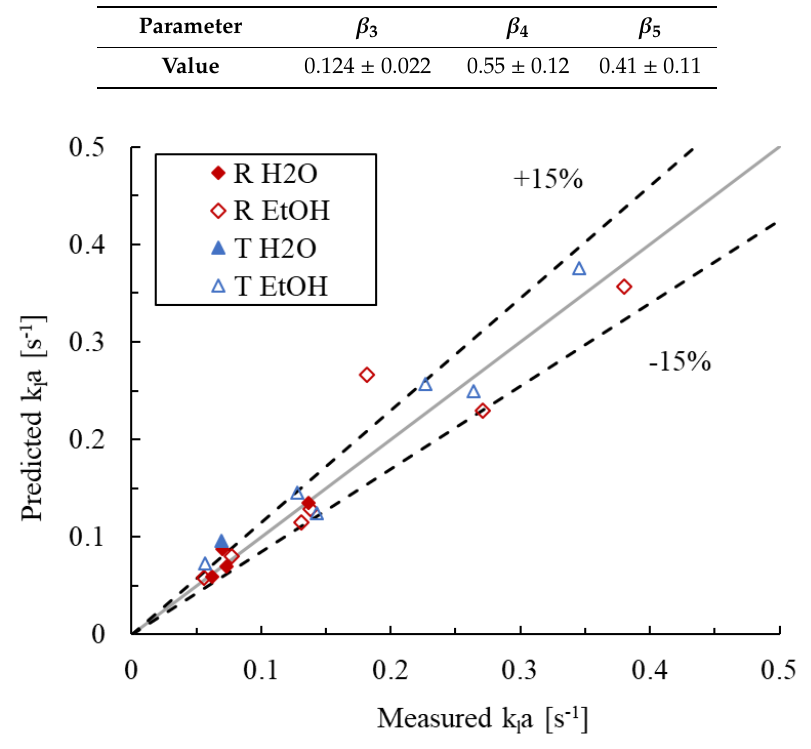
Table 3. k l a model fits and 95% confidence intervals for LL-Rhombus and LL-Triangle with water and 0.5 wt% aqueous ethanol as the liquid phases over the ranges of 0.565 < (cid:15) < 6.91 W / kg and 0.14 < u g / u l < 0.56.